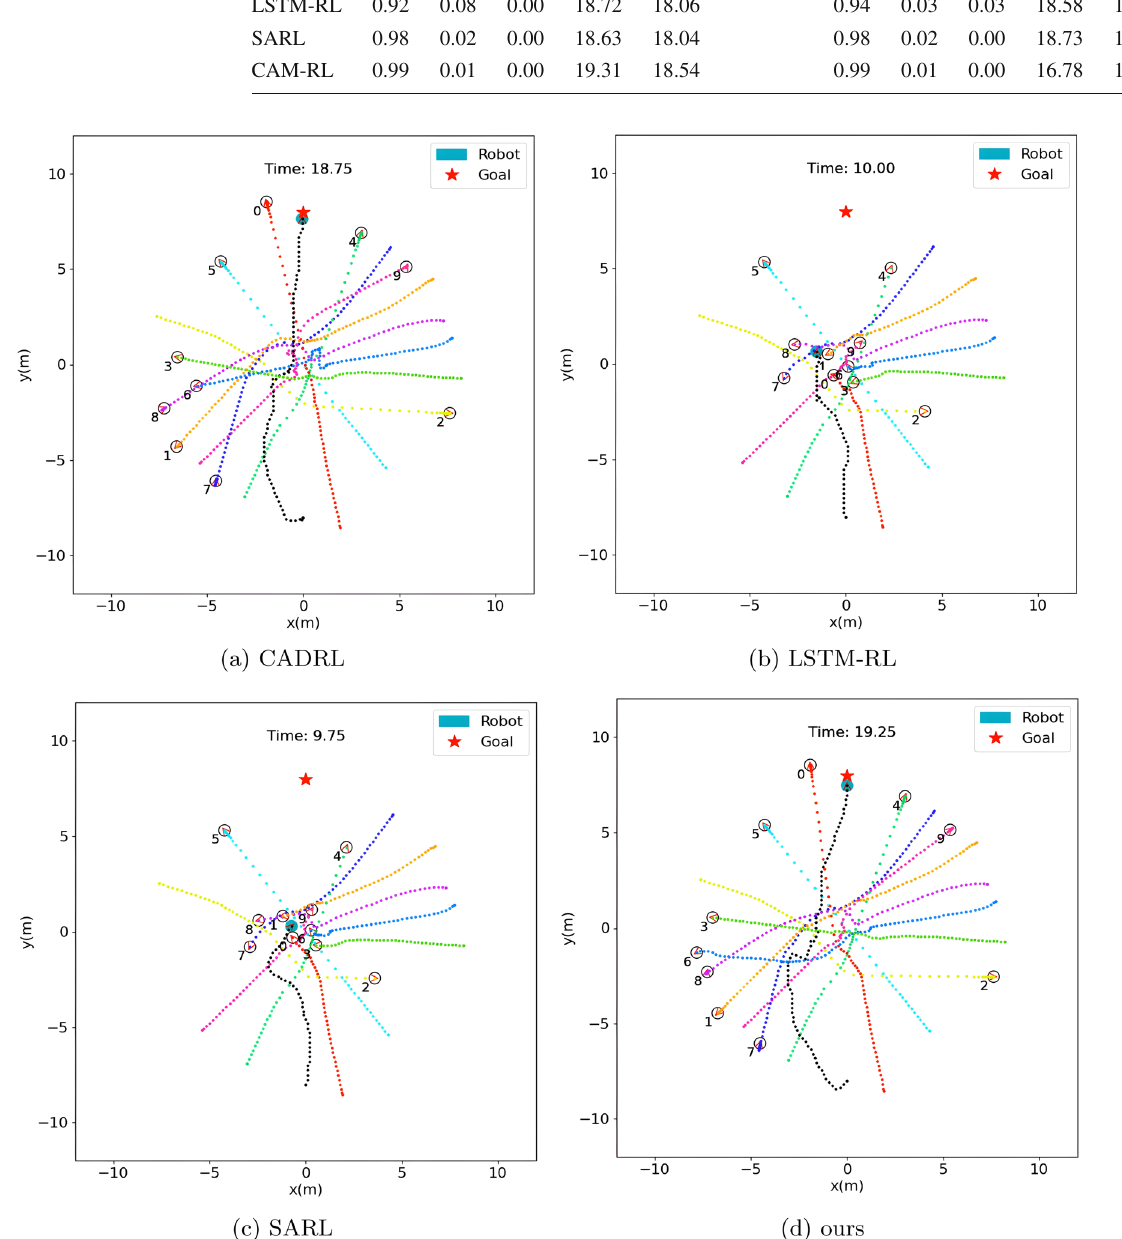
Fig. 5 A test case scenario of robot navigation in circular crossing scenario with ten humans